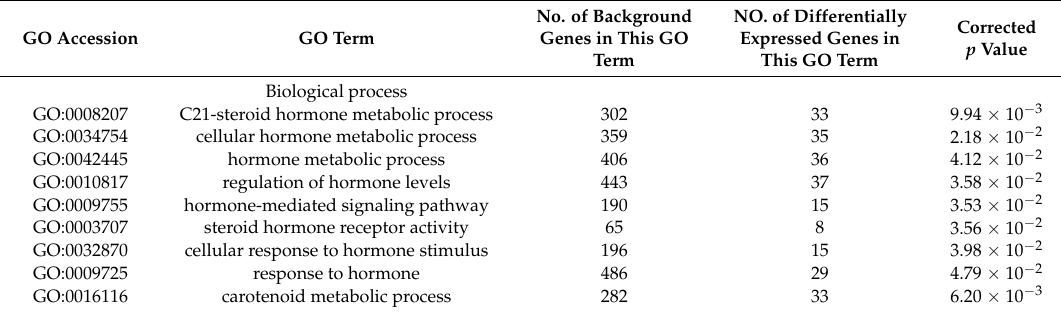
Table 2. Identification of over-represented GO term for phytohormone in DEG